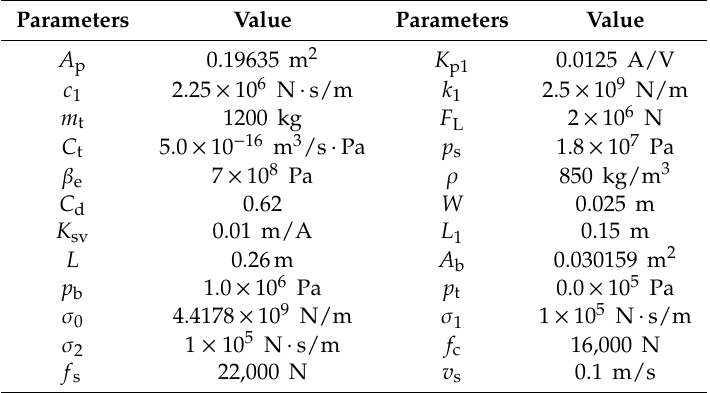
Table 1. Nominal value of main parameters of hydraulic screw down